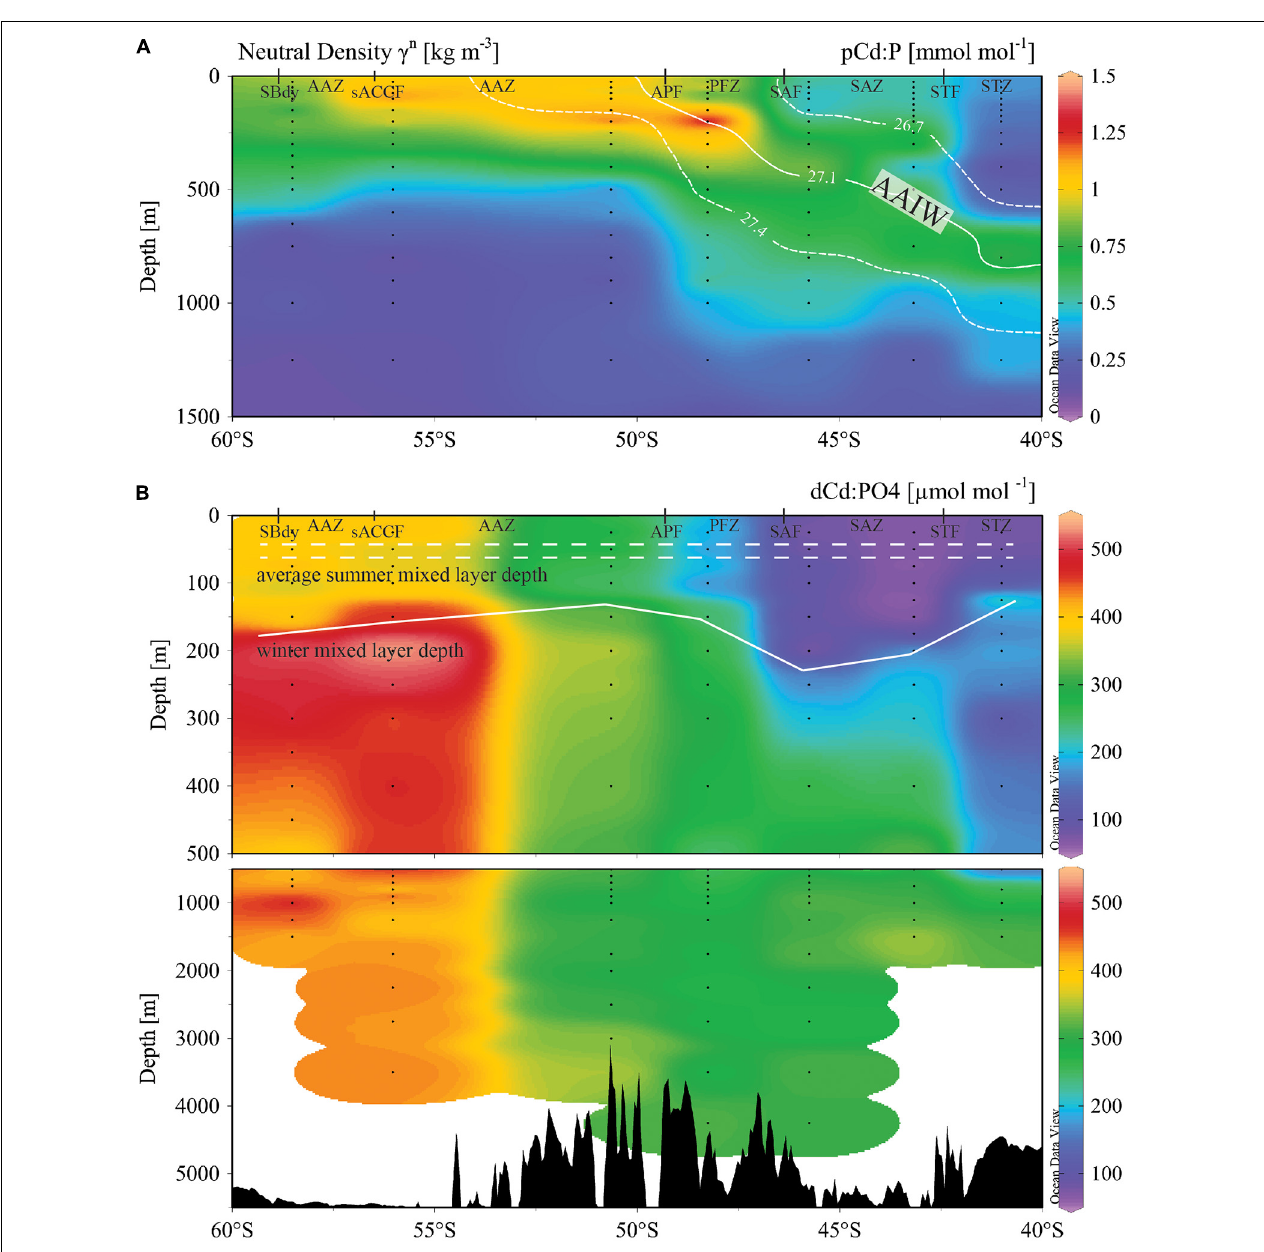
FIGURE 7 | Distribution plots of (A) pCd:P spot ratios for the upper 1,500 m and (B) dCd:PO 4 spot ratios separated into upper 500 m (upper panel) and below 500 m (bottom panel). Frontal position and corresponding zones are shown. In (A) , the solid white line is the median isopycnal defining Antarctic Intermediate Water (AAIW) and the dashed white lines are the upper and lower isopycnal limits for AAIW. In (B) , dotted lines represent the average range of the summer mixed layer depth [data from WOCE Global Data Resource (2018)]. Solid line represents the calculated winter mixed layer depth during this study. Figure constructed using Ocean Data View (ODV; Schlitzer,